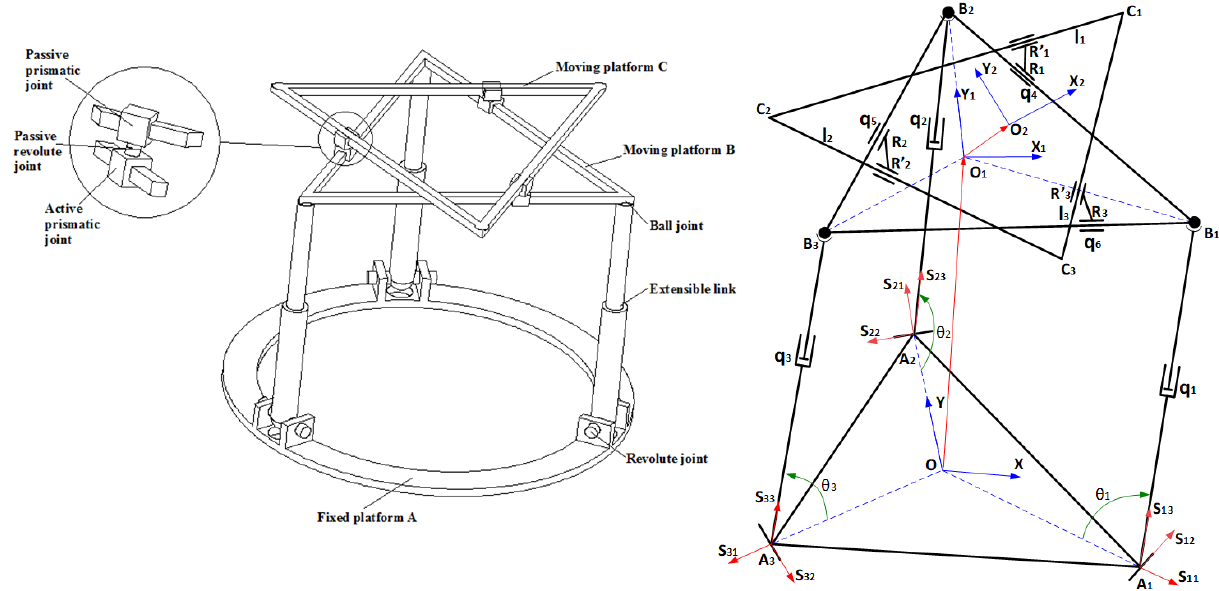
Figure 3. Schematic of the basic concept and kinematic representation of the mechanical architecture.